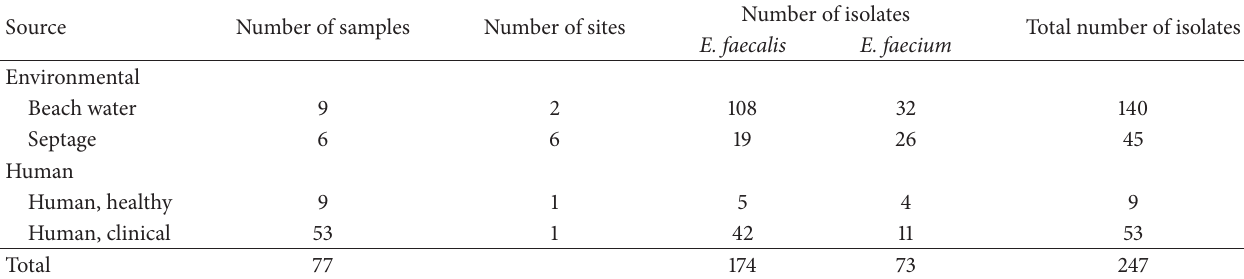
Table 2: Sources of E. faecalis and E. faecium isolated from Puerto